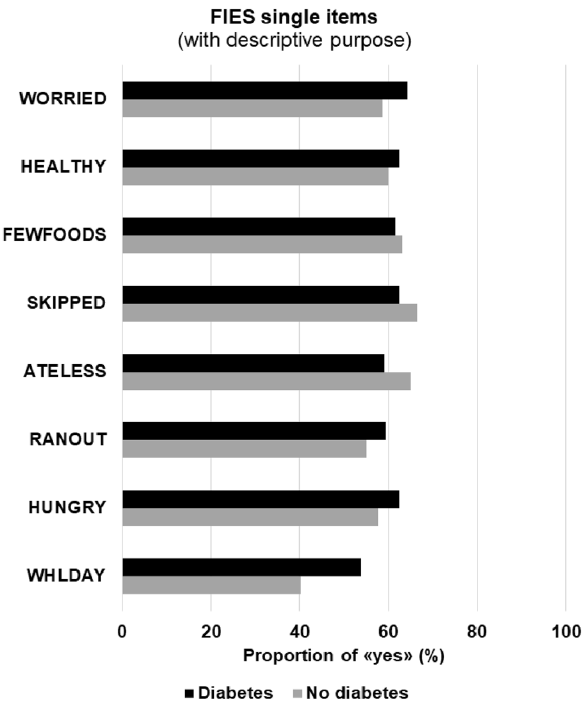
Figure 2. Single items of FIES in cases and